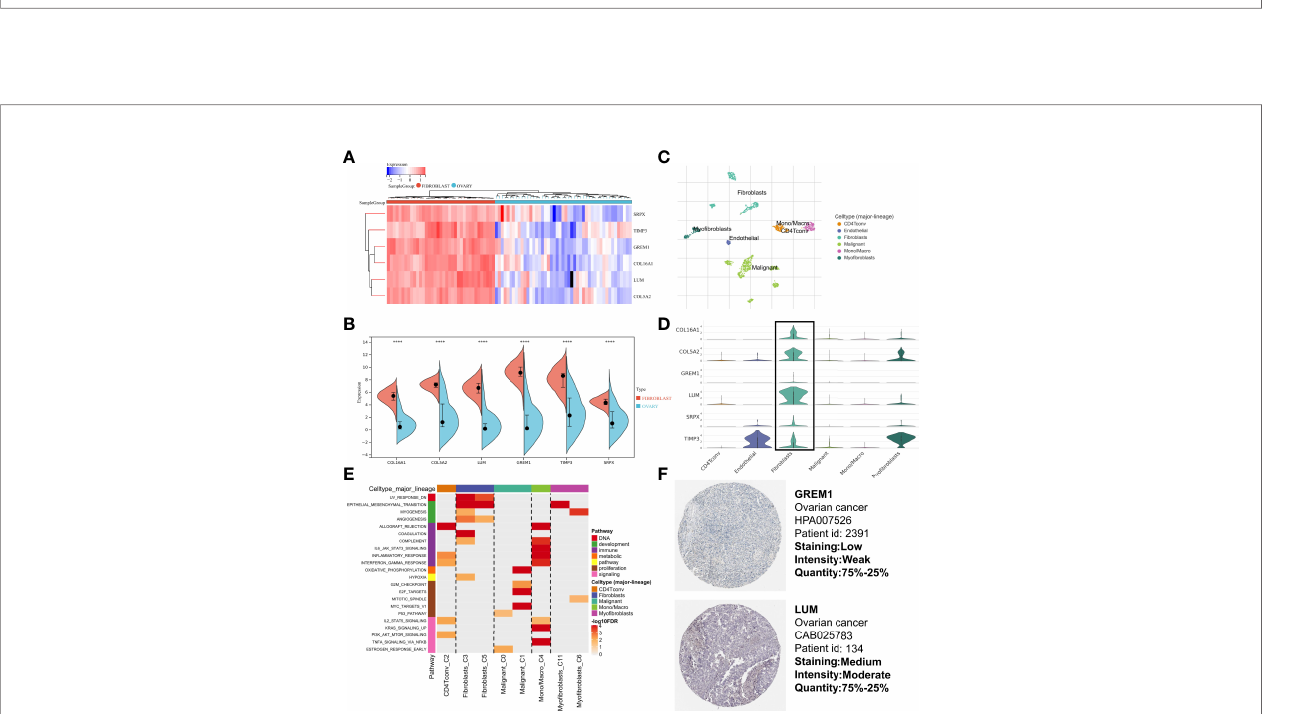
FIGURE 10 | Multidimensional expression validation. (A) Heatmap of gene expression in different cell lines based on “ limma ” package. (B) Wilcoxon test of gene expression in different cell lines. (C) Major cell type in single-cell seq. (D) Differential distribution of gene expression at the single-cell level. (E) GSEA of upregulated genes in different cell types. (F) IHC images of OC tissues from the HPA database. GSEA, Gene Set Enrichment Analysis; OC, Ovarian cancer; IHC, Immunohistochemistry; HPA, Human Protein